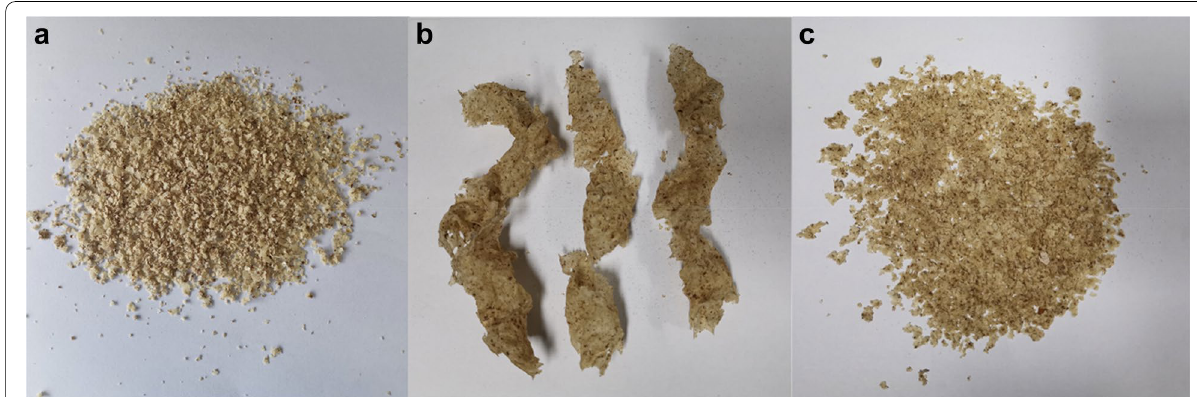
Fig. 2 Cake obtained by pressing oil from rubber seed kernels with different particle sizes ( a ) 3.5 mm; ( b ) 7 mm; ( c ) 10.25 mm